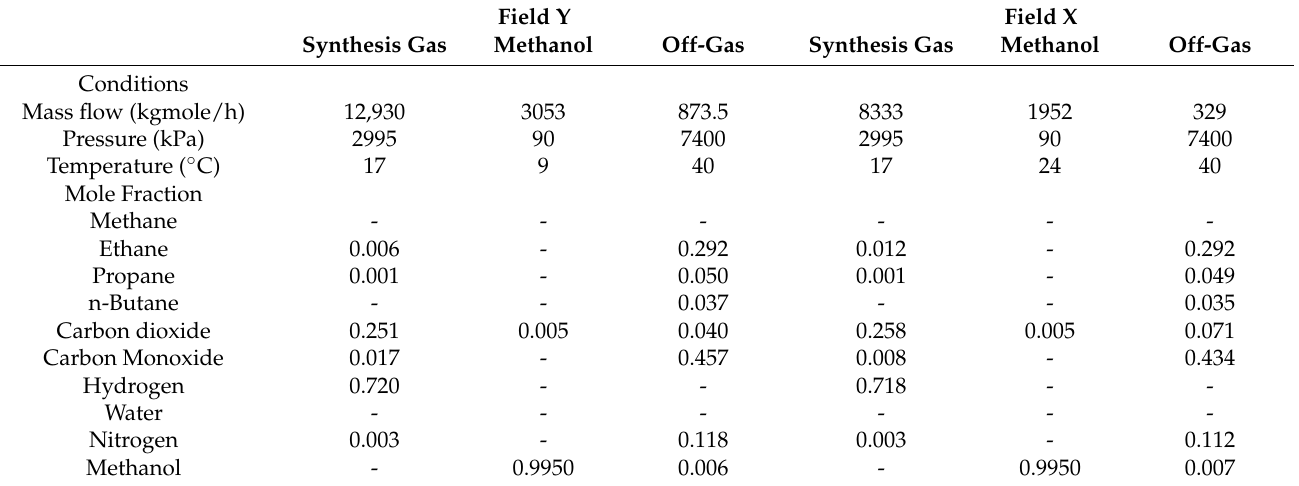
Table 9. Properties of the gases produced after the simulation for Fields Y and